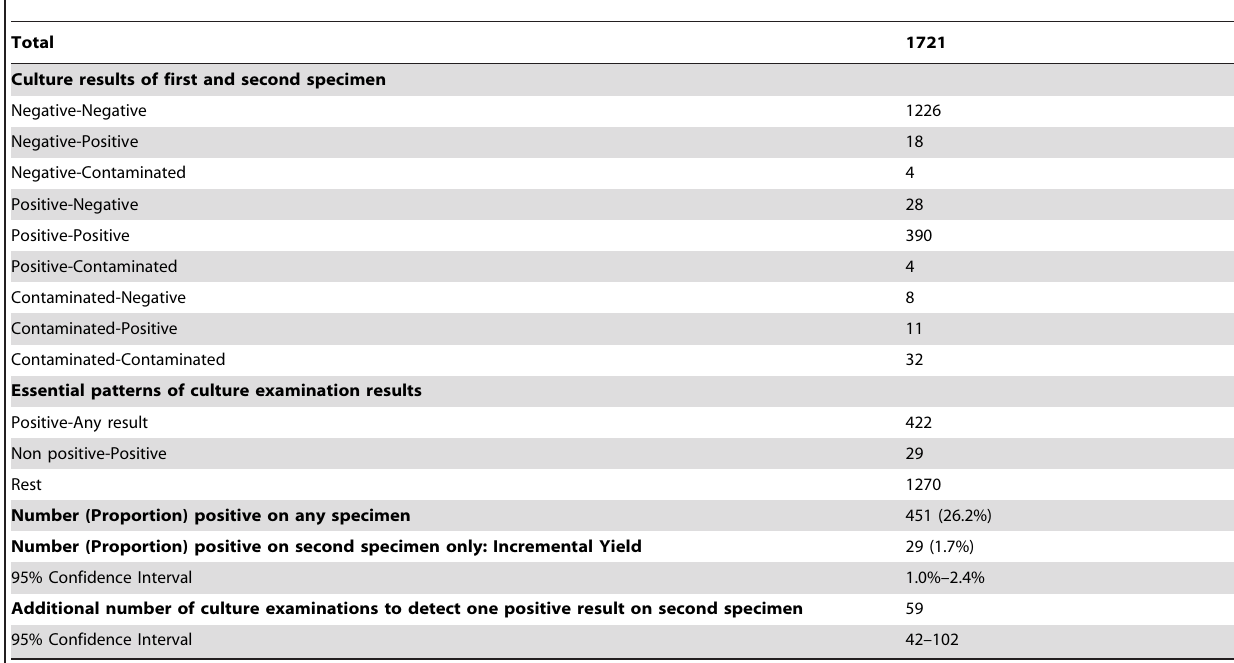
Table 2. Incremental yield of second specimen during follow-up culture examinations among Multi Drug Resistant Tuberculosis patients registered in 2008–09,